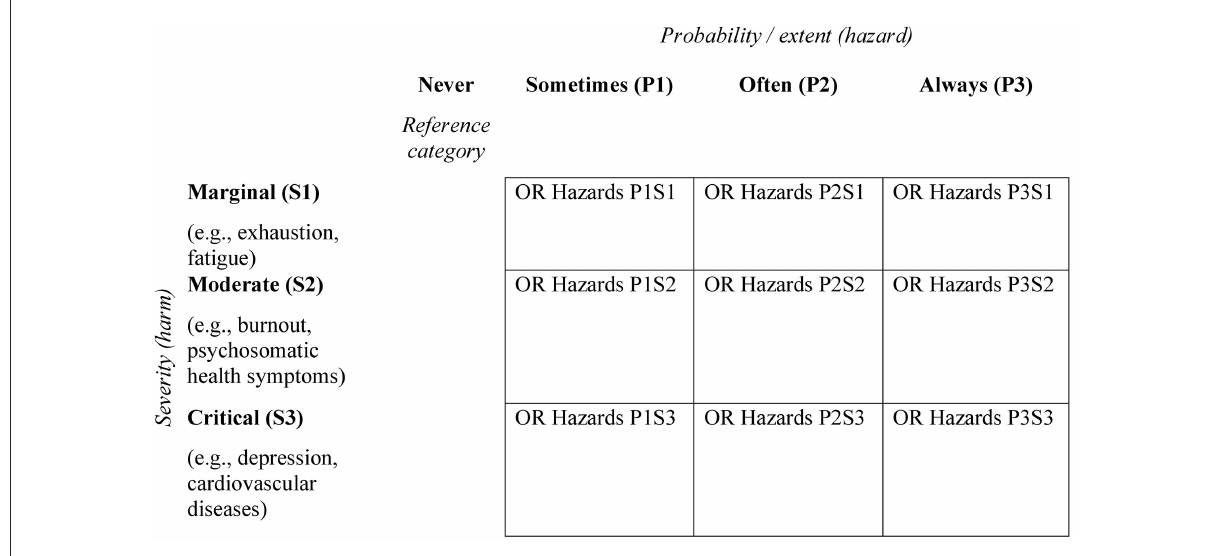
FIGURE3 Graphical edition of the RMA for psychosocial hazards. OR, odds